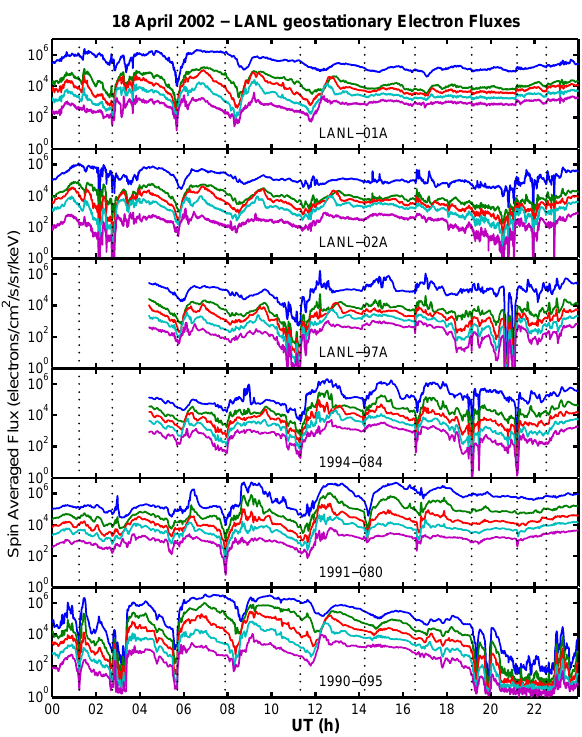
Fig. 3. Electron flux measured by the geostationary LANL satellites on 18 April 2002. The energy channels are 50–75keV (blue), 75– 105keV (green), 105–150keV (red), 150–225keV (cyan) and 225– 315keV